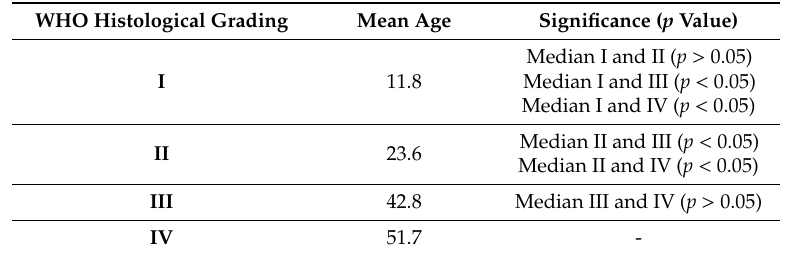
Table 1. Comparison of World Health Organization (WHO) grade of malignancy x